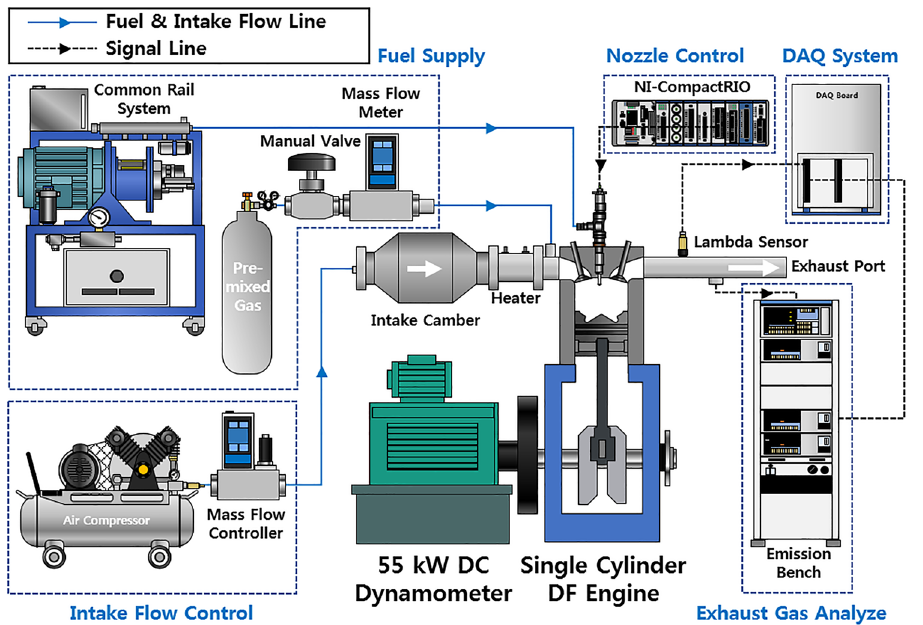
Figure 1. Schematic of apparatus used in the